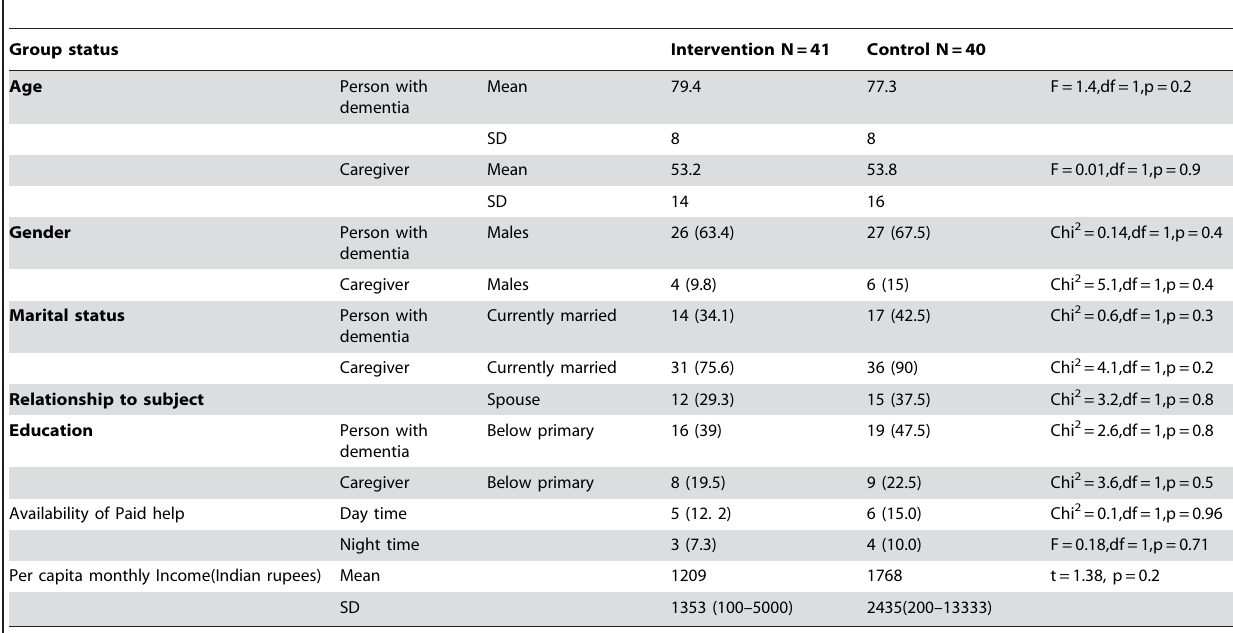
Table 1. Baseline characteristics of the sample of dyads of persons with dementia and caregivers in a RCT of a community intervention for dementia in Goa, India